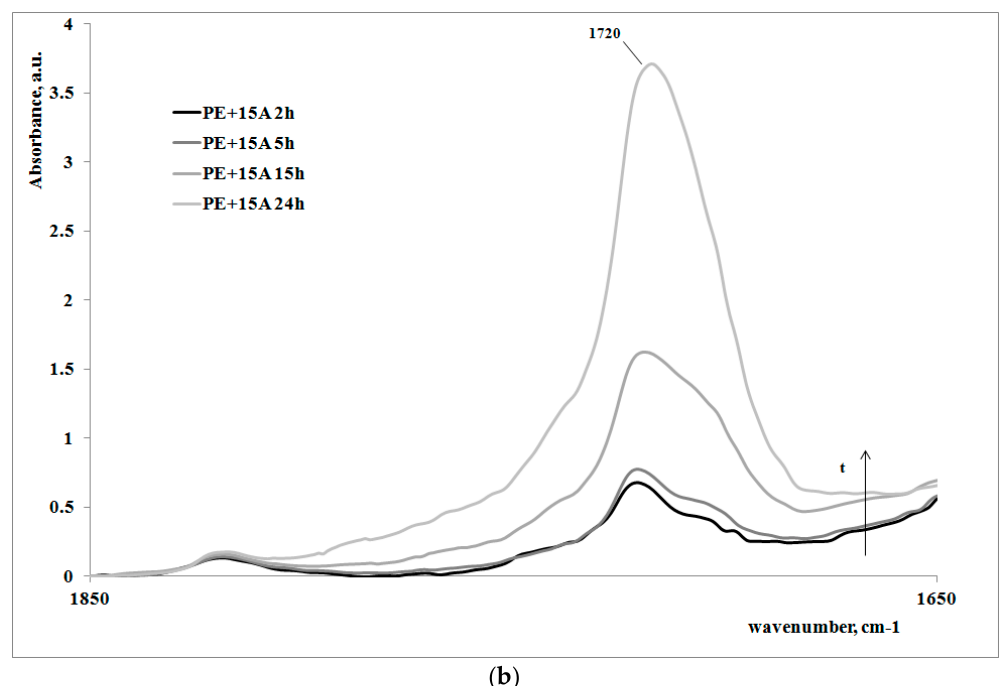
Figure 4. FTIR spectra of some irradiated and non-irradiated samples of polyethylene matrix ( a ) and nanocomposite ( b ).